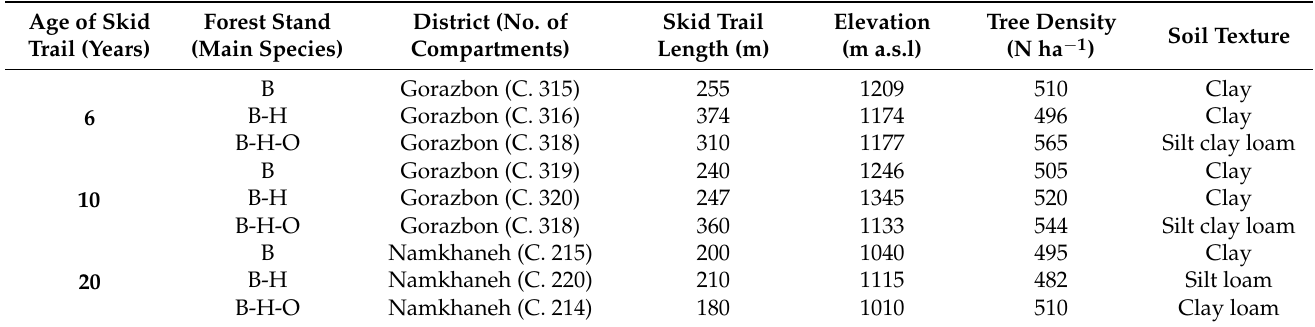
Table 1. The characteristics of each of the forest stands and skid trails. B: (beech); B-H: (beech, hornbeam); B-H-O: (beech, hornbeam, Cappadocian maple, Caucasian alder, large-leaved lime tree and mountain elm).